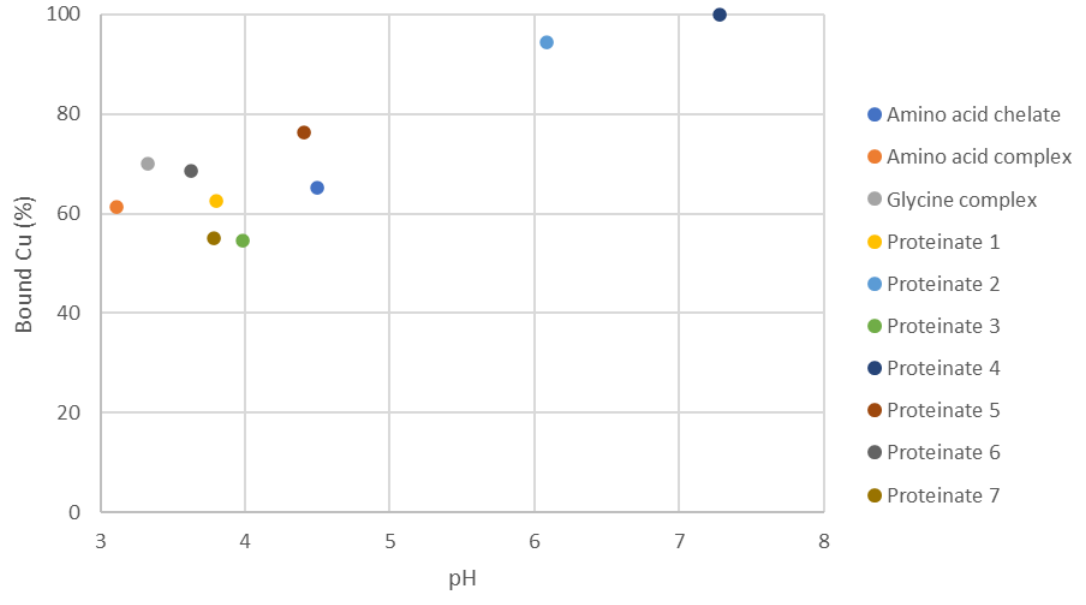
Figure 7. Scatter plot of initial pH of commercial OTMs and their respective bound copper values. Most of the samples were seen to form an insoluble precipitate above pH 5.5, and this phenomenon can be observed as inflections in the curves for these OTMs in Figure 8. When this occurred, it was not possible to continue with the titration.